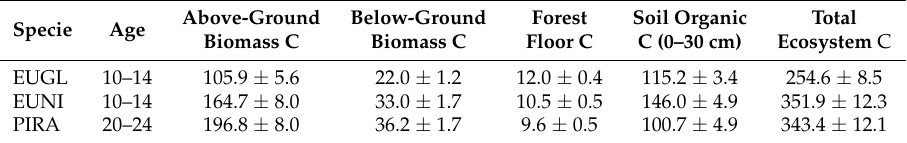
Table A3. Average ( ± standard deviation, n = 11,084) carbon (C) stocks [Mg · ha − 1 ] in each specie at rotation age (10–14 years-old for EUGL and EUNI, 20–24 years-old for